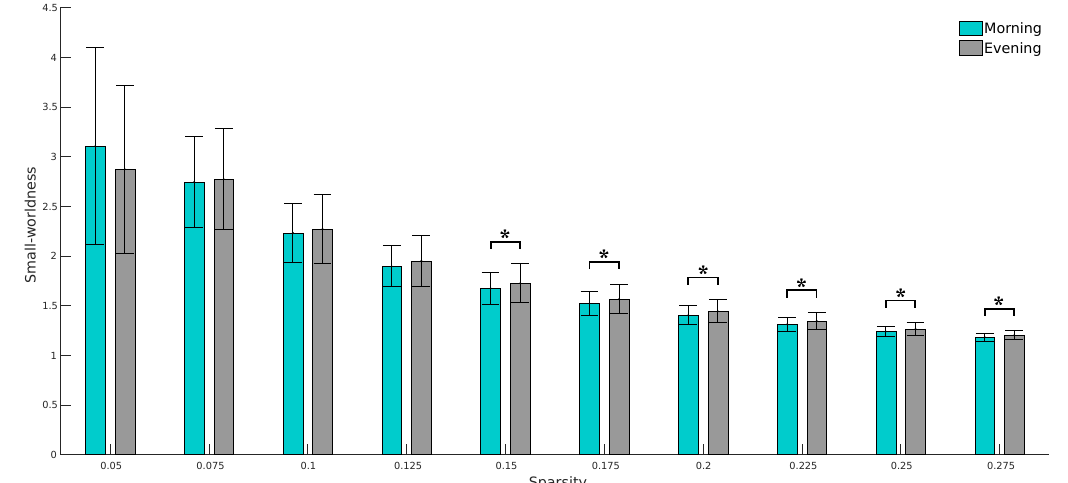
Figure 2. Results of paired t -test on the small-worldness at the threshold values of 0.05 to 0.275. Asterisks (*) in the figures show a significant difference in small-worldness between sessions ( p < 0.01, Bonferroni